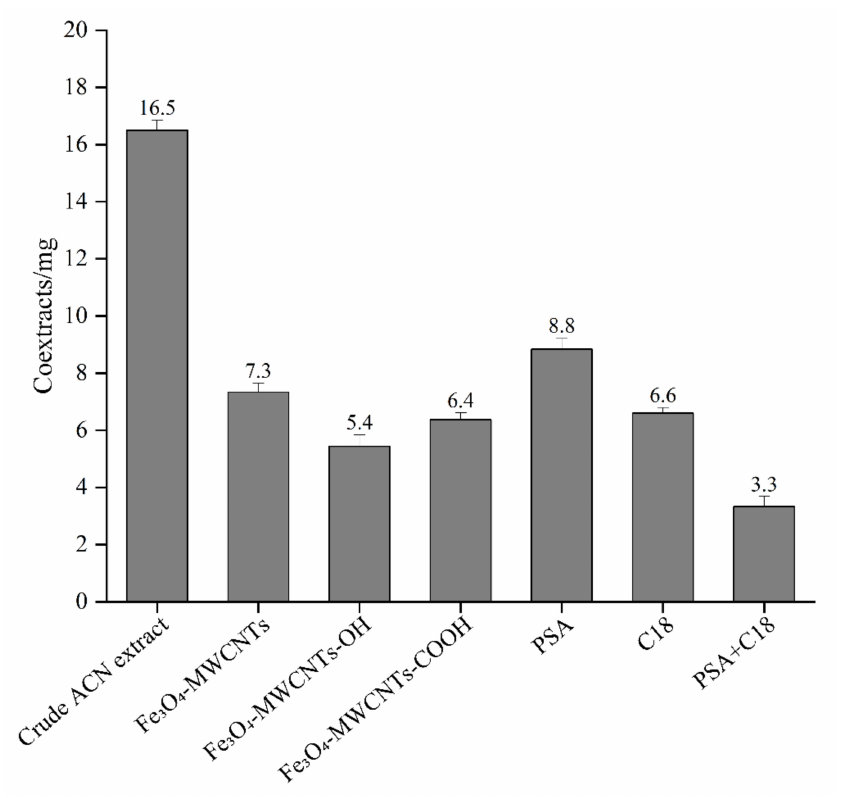
Figure 3. Amount of matrix co-extracts obtained through gravimetric measurement after purification with different clean-up materials ( n =